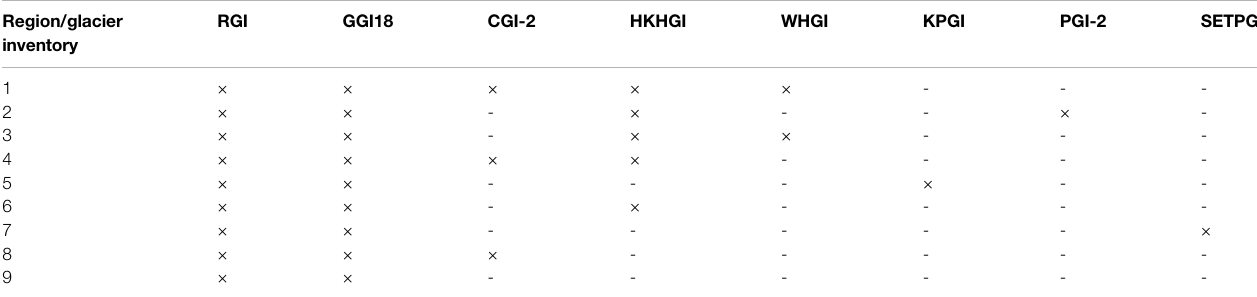
TABLE 2 | Spatial coverage of the glacier inventory products, in accordance with the regions where the different products overlap. Region/glacier